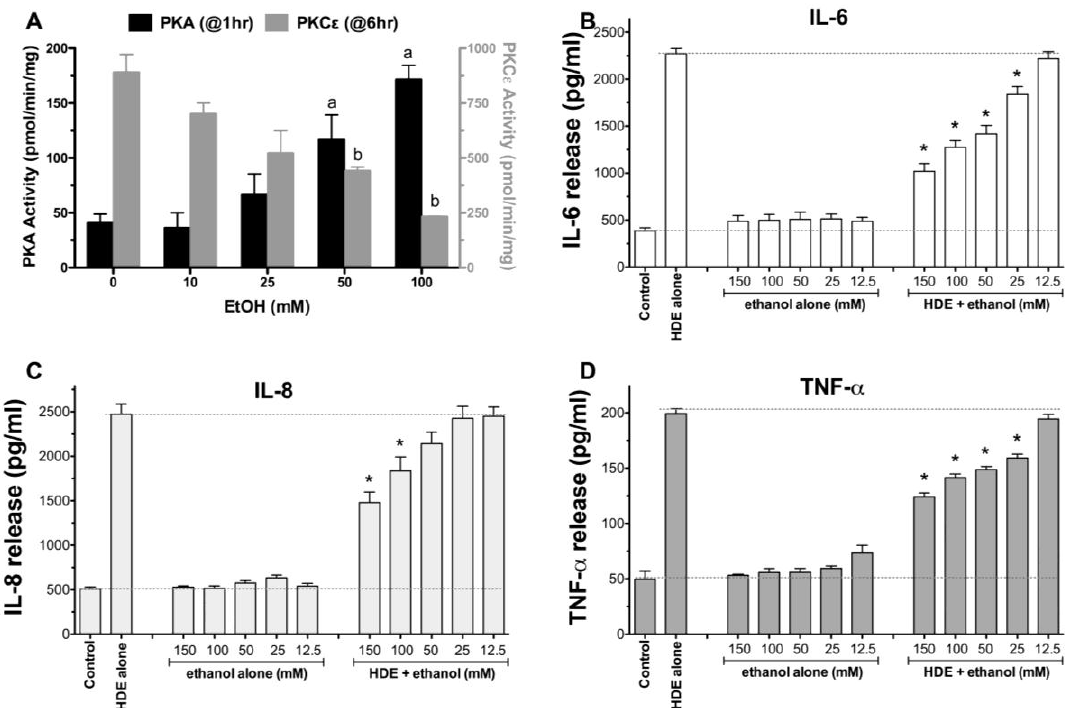
Figure 1. Ethanol dose-dependently activates protein kinase A (PKA) and inhibits hog CAFOs dust extract (HDE)-induced cytokine release from BEAS-2B cells. Bronchial epithelial cells (BEAS-2B) were pretreated with various concentrations of EtOH (12.5 to 150 mM) for 1 h before being exposed to 5% HDE (±EtOH) for an additional 24 h. EtOH dose-dependently increases PKA activity at 1 h ( A ; black bars) and decreases HDE-stimulated PKC epsilon activity at 6 h ( A ; gray bars). Inflammatory cytokines IL-6 ( B ); IL-8 ( C ); TNF α ( D ) measured in culture supernates by ELISA. a p < 0.05 vs. 0 mM EtOH for PKA; b p < 0.05 vs. 0 mM EtOH for PKC ε ; * p < 0.05 vs HDE alone for n = 3 or 4 independent experiments (ANOVA, Tukey’s post test).